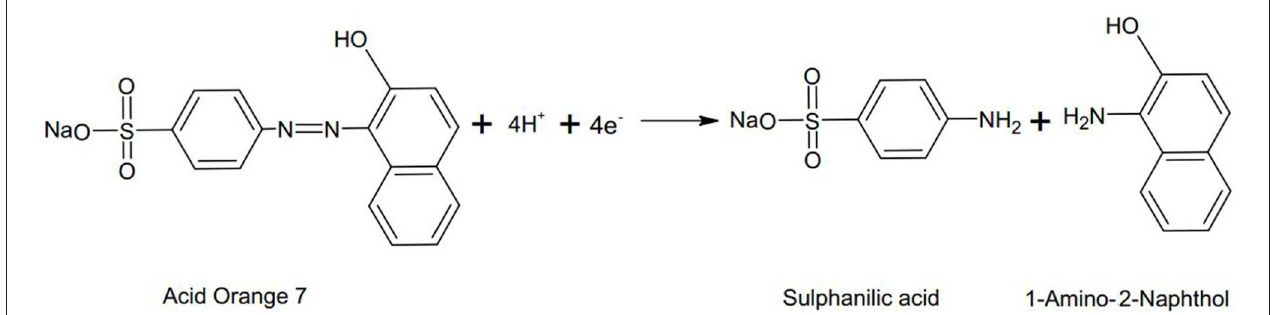
TABLE 1 | Features of dye degradation in the anode vs. cathode of MFCs. Anode dye degradation Cathode dye degradation I. Microbially mediated II. Reductive process forming aromatic amines III. Mechanism not clear- Azo